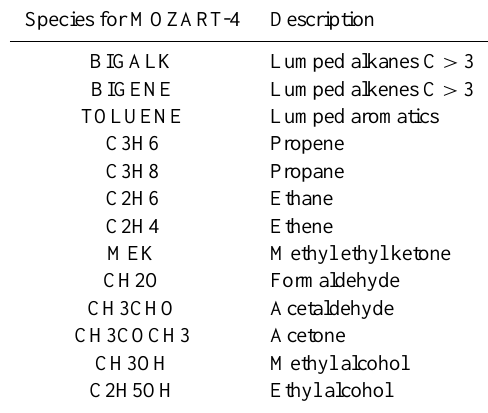
Table A4. Description of MAZART-4 NMVOC emitting species from anthropogenic sources ∗